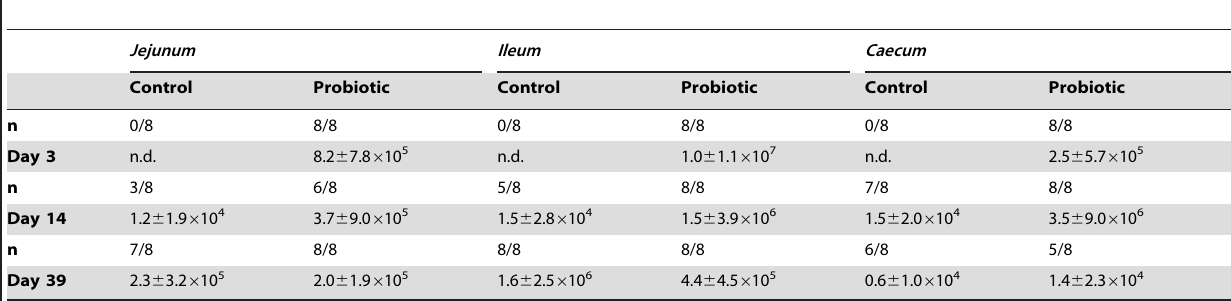
Table 2. Mean numbers of L. reuteri LR in chicken gut samples from animals fed without (control) or with LR (probiotic) over 39 days as determined by strain-specific